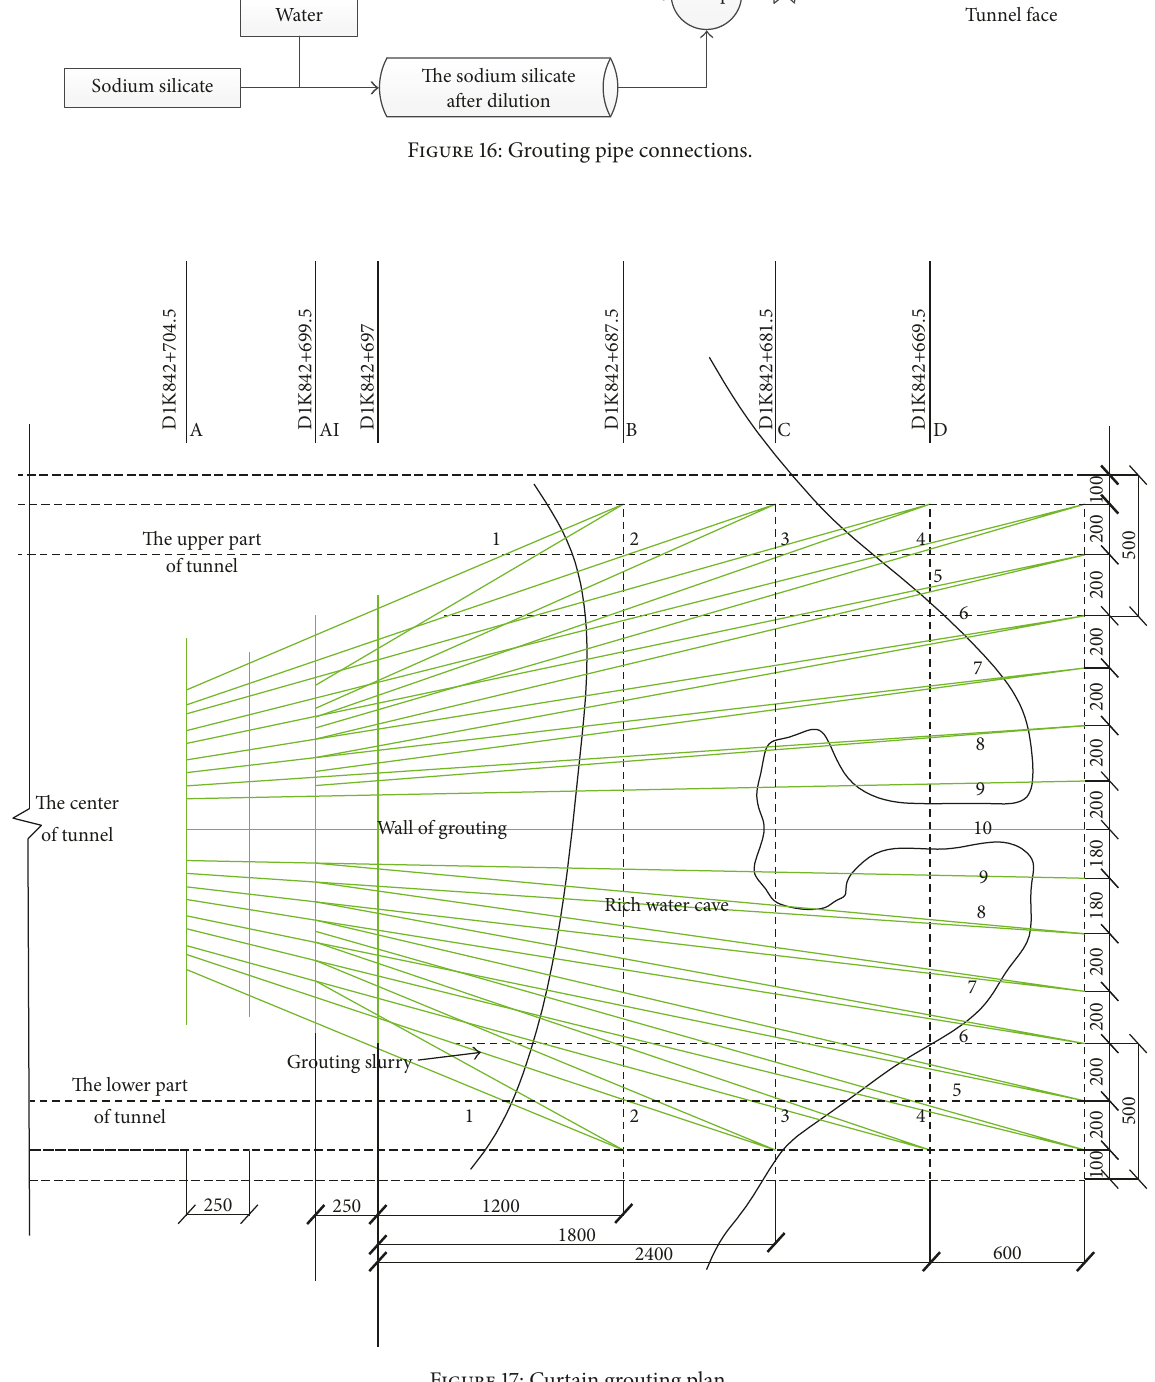
Figure 17: Curtain grouting